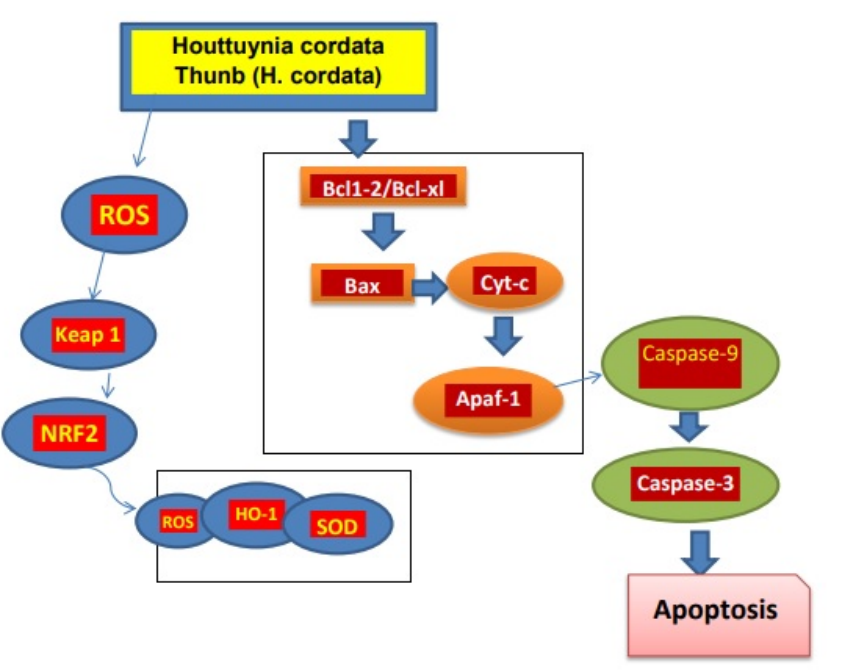
Figure 2. Mechanism of H. cordata acts as an anti-tumor agent. H. cordata suppresses cancerous cells by blocking NRF2/Bcl1, Bcl-xl signaling pathway and leading to apoptosis of cancerous cells